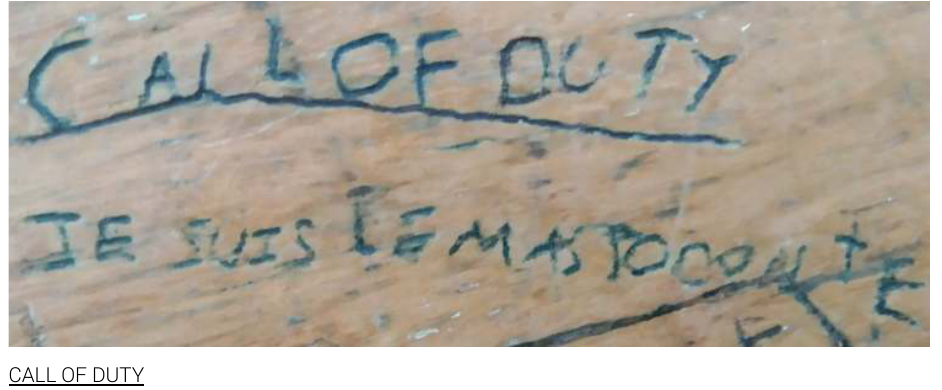
Table 3 e: Gaming reference found on desktops at the University of Bordeaux